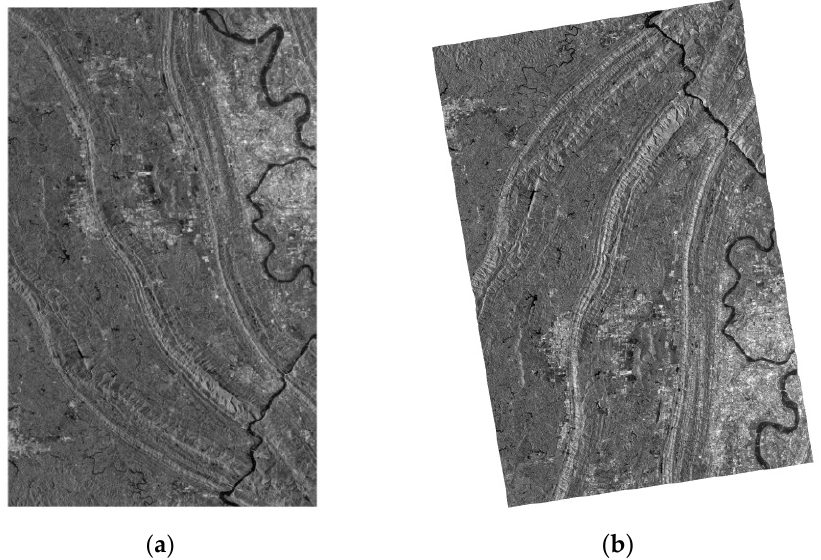
Figure 5. Terrain correction of ALOS-2 data. ( a ) Before terrain correction; (b) After terrain correction.